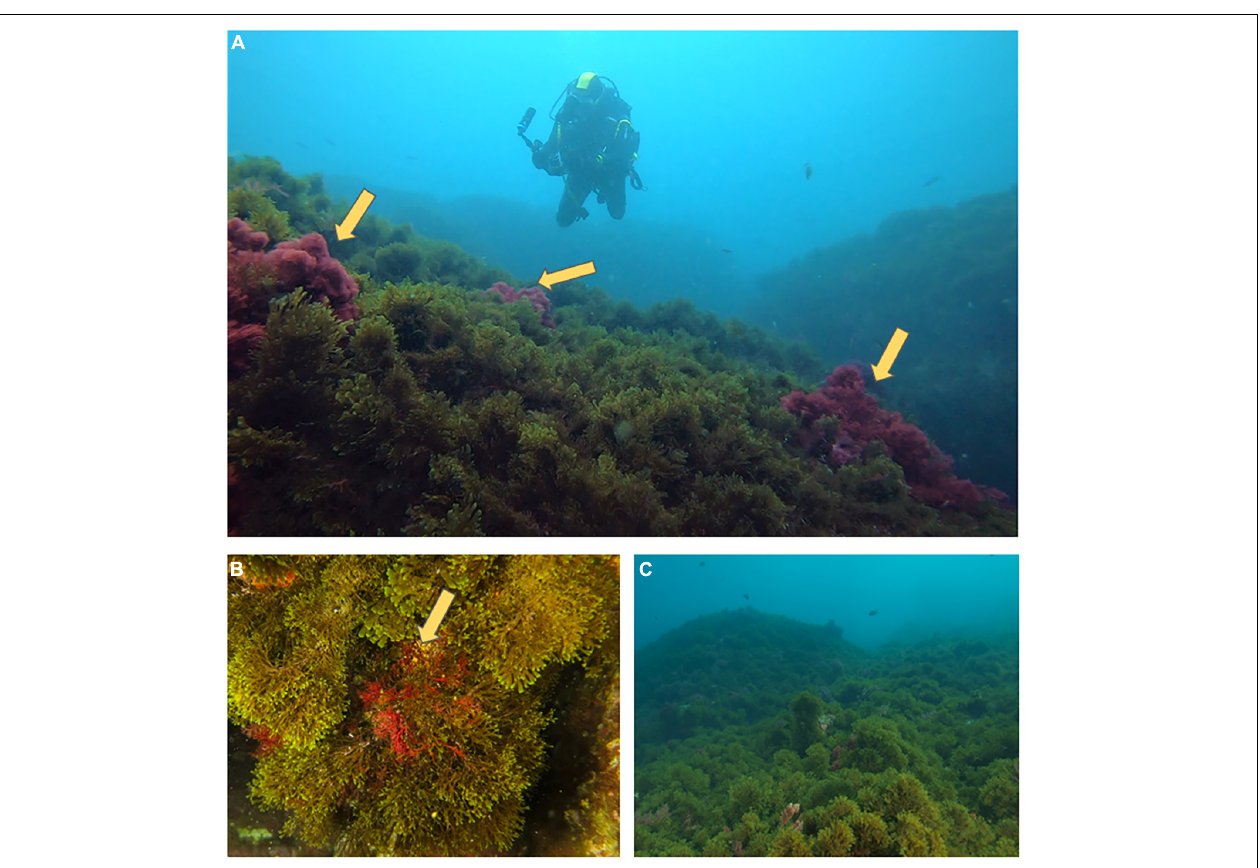
FIGURE 7 | Resident benthic species exclusion and subsequent monopolization of the space by R. okamurae in the rocky bottoms of the Strait of Gibraltar. (A) First scheme of R. okamurae establishment on rocky substrata of the Strait of Gibraltar (–10 m depth) in the presence of resident species, as Sphaeroccocus coronopifolius (arrows). (B) S. coronopifolius expressing signs of degeneration (arrow) after/while interacting with the introduced species. (C) Resident species lost and subsequent monopolization of rocky bottoms by R. okamurae